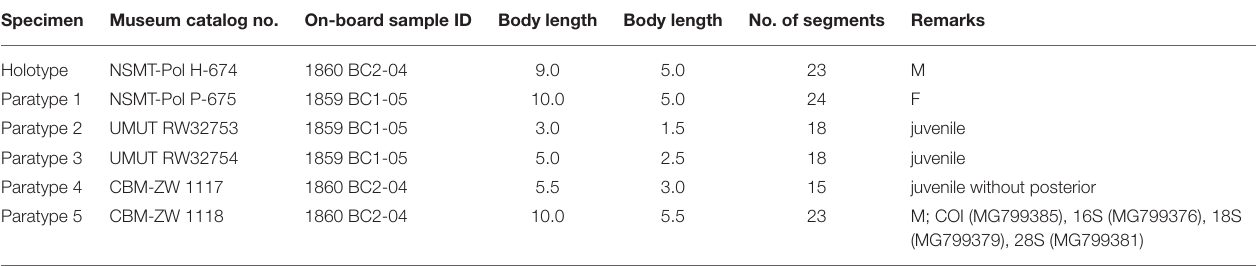
TABLE 4 | General information of examined specimens of Levensteiniella undomarginata sp.